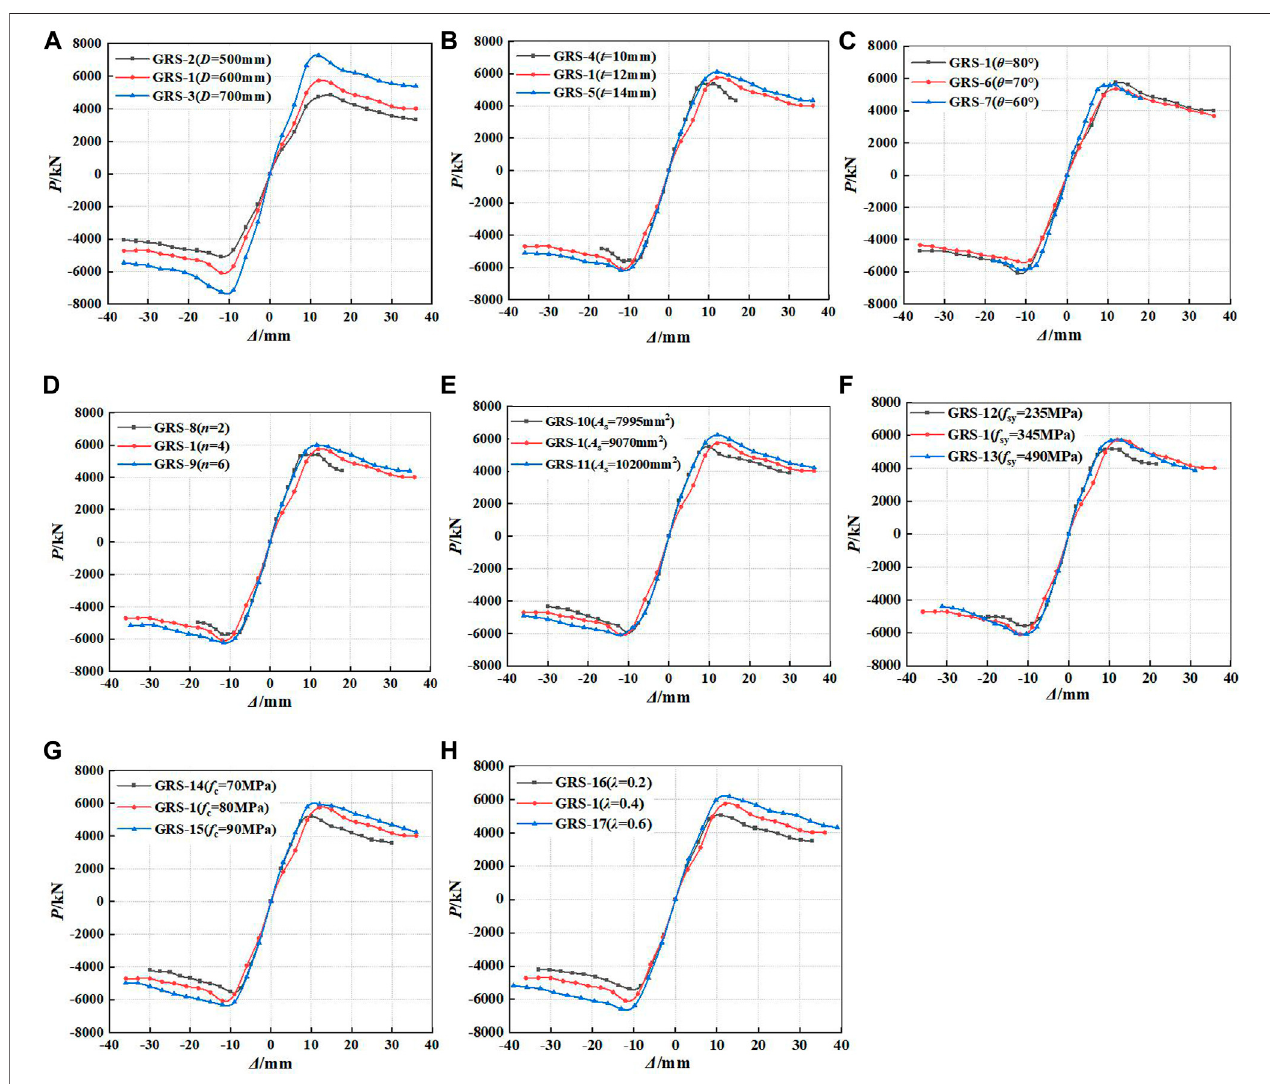
FIGURE 11 | Comparisons of skeleton curves: (A) different diameters of GFRP tube; (B) different thicknesses of GFRP tube; (C) different fi ber winding angles; (D) differentnumbersof fi berwindinglayers; (E) differentareasofencasedsteel; (F) differentstrengthsofencasedsteel; (G) differentcompressivestrengthsofRPC;and (H) different axial compression